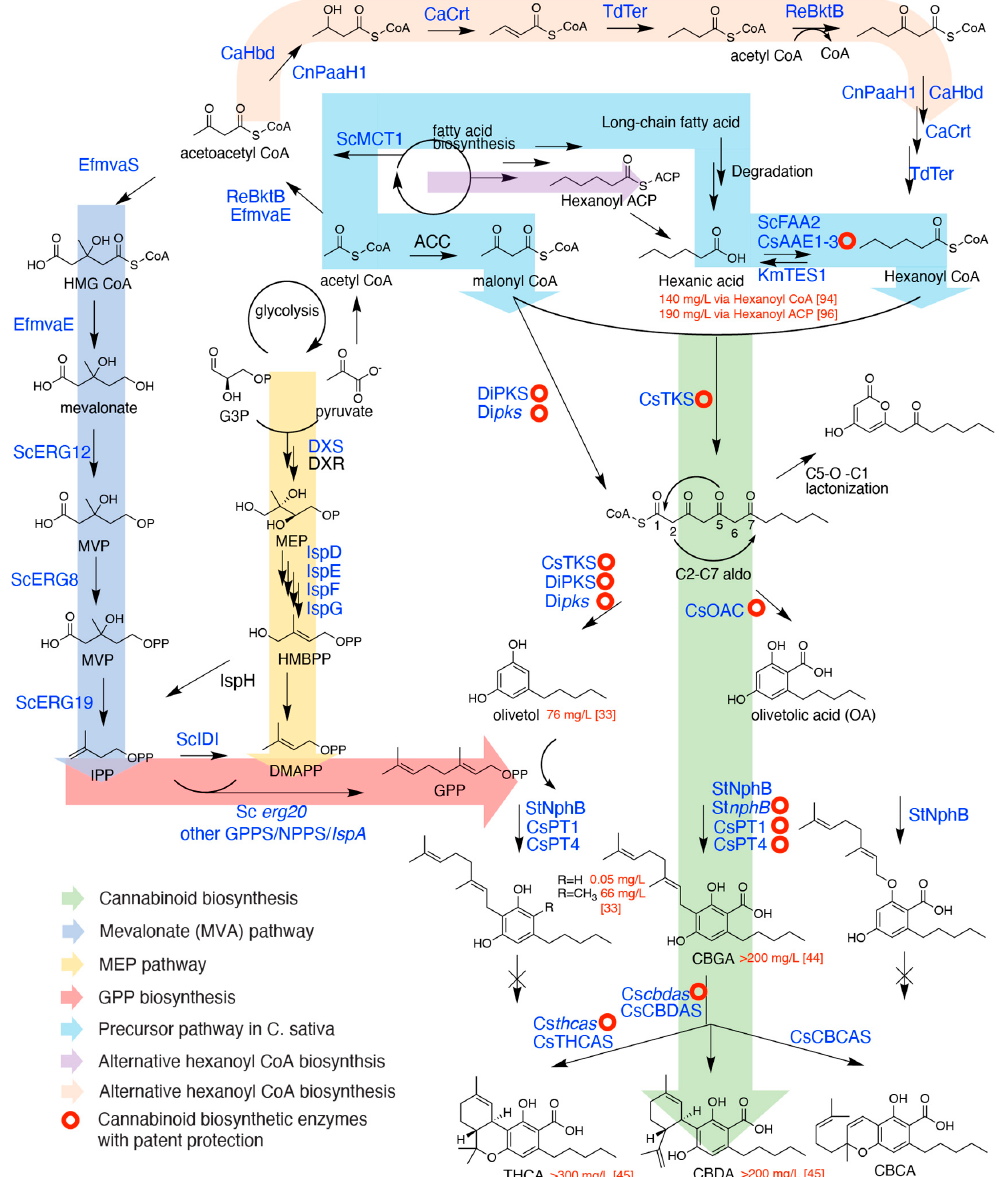
Figure 2. The native and engineered biosynthetic pathway for phytocannabionids in C. sativa . Enzymes in italics are mutant enzymes. The abbreviations are listed as follows. The cannabinoid pathway: TKS, tetraketide synthase; OAC, olivetolic acid synthase; PKS, polyketide synthase; NphB, naphterpin biosynthetic cluster gene B; PT, prenyltransferase; THCAS, tetrahydrocannabinolic acid synthase; CBDAS, cannabidiolic acid synthase; CBCAS, cannabichromenic acid synthase. MVA pathway: mvaE, acetoacetyl-CoA thiolase/HMG-CoA reductase; mvaS, HMG-CoA synthase; ERG12, mevalonate kinase; ERG8, phosphomevalonate kinase; ERG19, diphosphomevalonate decarboxylase; IDI1 isopentenyl diphosphate:dimethylallyl diphosphate isomerase; ERG20, farnesyl pyrophosphate synthetase. MEP pathway: DXS, deoxyxylulose 5-phosphate synthase; DXR, deoxyxylulose 5-phosphate reductoisomerase; IspD, 4-diphosphocytidyl- 2-C-methylerythritol (CDP-ME) synthase; IspE, CDP-ME kinase; IspF, 2- C -methyl- D -erythritol 2,4-cyclodiphosphate synthase; IspG, (E)-4-Hydroxy-3-methyl-but-2-enyl pyrophosphate (HMB-PP) synthase; IspH, HMB-PP reductase. Fatty acid biosynthesis: BktB, β -keto thiolase; ACC, acetyl CoA carboxylase; MCT1: malonyl CoA-acyl carrier protein transacylase; HBD/PaaH1, β -hydroxybutyryl-CoA de-hydrogenase; CRT: 3-hydroxybutyryl-CoA dehydratase; Ter, trans-enoyl-CoA reductase; FAA2, Long-chain-fatty-acid–CoA ligase 2; KmTES1, Kluyveromyces marxianus acyl-CoA thioesterase; AAE: acyl activating enzyme. Species abbreviations: Cs, Cannabis sativa ; St, Streptomyces strain CL109; Di, Dictyostelium discoideum ; Ef, Enterococcus faecalis ; Re, Ralstonia eutropha ; Ca, Clostridium acetobutylicum ; Td, Treponema denticola ; Sc, Saccharomyces cerevisiae ; Km, Kluyveromyces marxianus